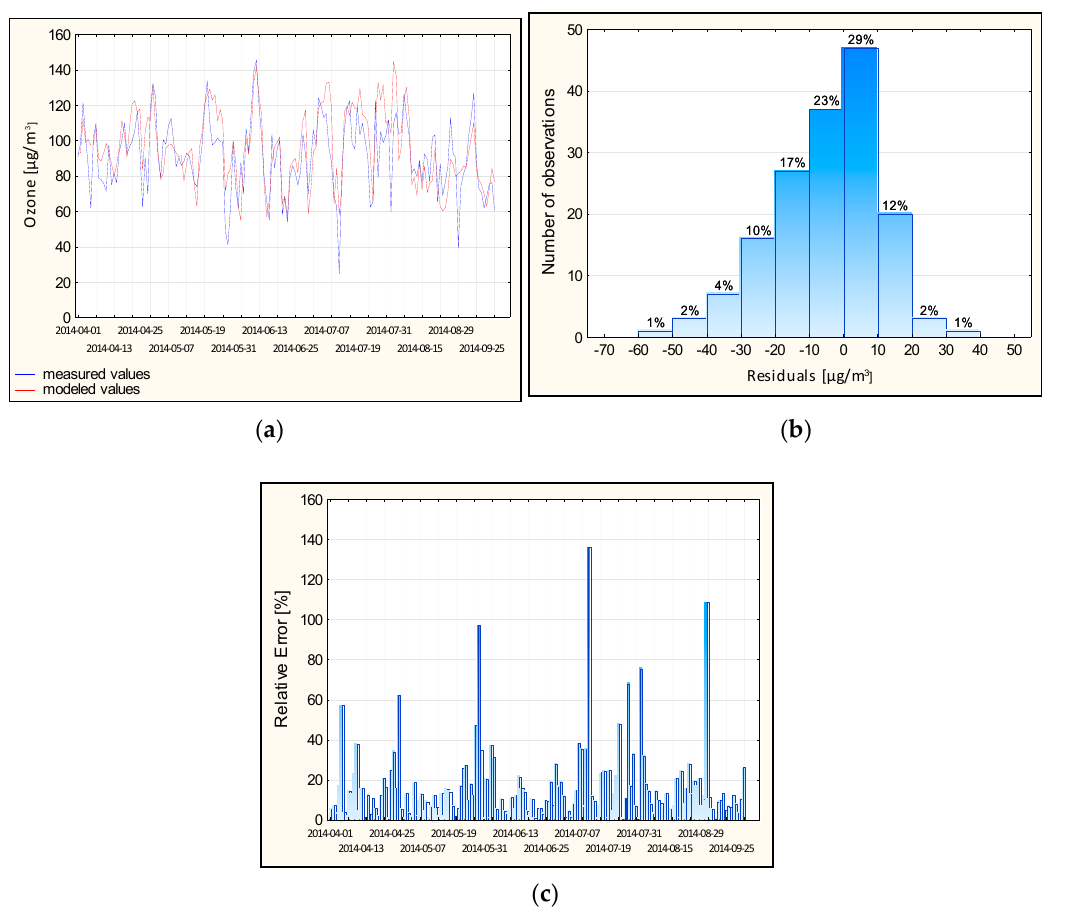
Figure 4. Results of modeling the daily maximum surface ozone concentration from April to September 2014 (Belsk station). ( a ) Graph of the course of measured and modeled surface ozone concentration values, ( b ) histogram of residual values, and ( c ) graph of the relative